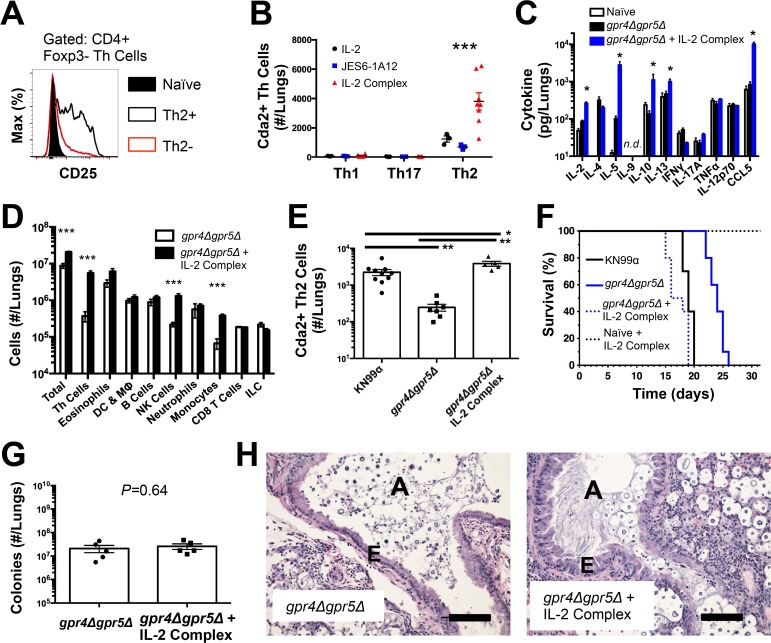
IL-2 Complexes Augment Type-2 Helper T Cells and Enhance Fungal Disease.(A) CD25 expression by naïve (CD4+, CD44−), Th2- (CD4+, CD44+, IL-5-, IL-13−), and Th2+ (CD4+, CD44+, IL-5+, IL-13+) cells. (B) Cda+ Th cell numbers in the lungs of gpr4Δgpr5Δ infected mice treated with 5 μg IL-2, 25 μg anti-IL-2 antibody (JES6-1A12), or both (IL-2 Complex). Th1, Th17, and Th2 cells were identified by production of IFNγ, IL-17A, and IL-5/13, respectively. (C) Cytokines from lung homogenates of mice infected with gpr4Δgpr5Δ or age-matched naïve animals, with or without IL-2 complex treatment. (D) Pulmonary leukocytes from mice infected with gpr4Δgpr5Δ, with or without IL-2 complex treatment. (E) Cda2+ Th2 cells from lungs of mice infected with fully virulent KN99α, attenuated gpr4Δgpr5Δ, or mice infected with gpr4Δgpr5Δ and treated with IL-2 complex. (F) Survival of naïve mice or mice infected with gpr4Δgpr5Δ either with or without IL-2 complex treatment. P-value represents log-rank test comparing each survival curve with 10 mice per group to: gpr4Δgpr5Δ vs. gpr4Δgpr5Δ + IL-2 complex, P<0.0005; gpr4Δgpr5Δ vs. KN99α, P<0.0005; gpr4Δgpr5Δ + IL-2 complex vs. KN99α, P = 0.23. (G) Fungal burden within lungs of mice with or without IL-2 complex 14 days post-infection with gpr4Δgpr5Δ. (H) Hematoxylin and eosin staining of lungs from mice infected with gpr4Δgpr5Δ or similarly infected and treated with IL-2 complexes. A = brochial airway, E = epithelial cell layer. Data are presented as the mean +/- standard error with at least 2 independent experiments per group. * = P < 0.05, ** = P < 0.005, *** = P < 0.0005 by Mann-Whitney U. Cda = chitin deacetylase, CCL = chemokine ligand, DC = Dendritic Cells, IFN = interferon, IL = interleukin, ILC = Innate Lymphoid Cells, MΦ = Macrophages, NK = Natural Killer. TNF = tumor necrosis factor.